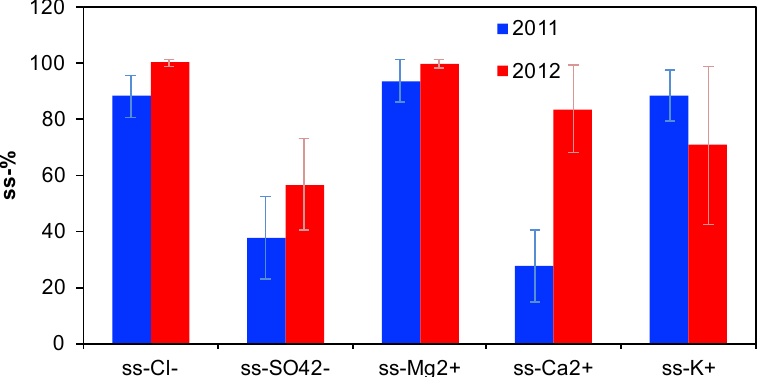
Figure 5. Average sea salt percentage of the major inorganic ions detected both during AREX2011 and AREX2012.